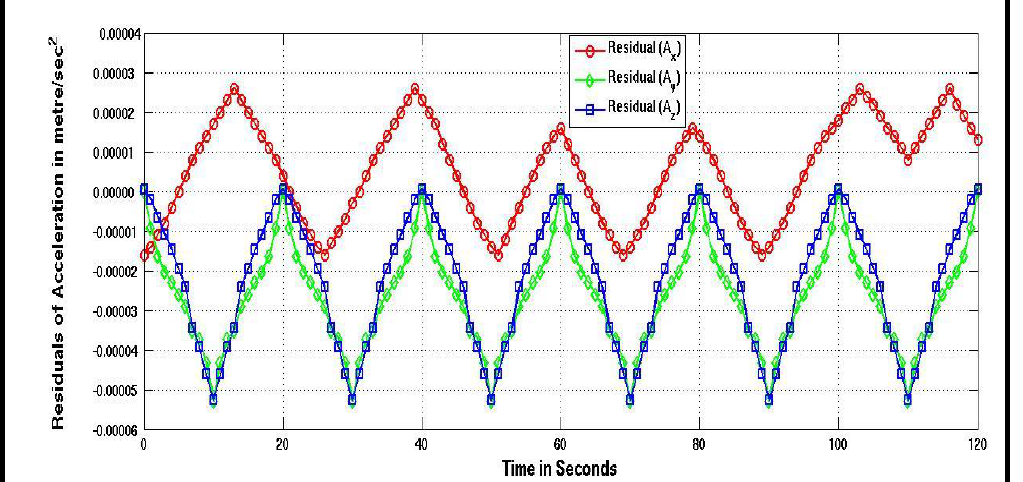
Fig. 6. Residual of 4 th order derived acceleration from precise one for Day of Year (DOY:138), starting from 18:00:00 to 18:02:00 for